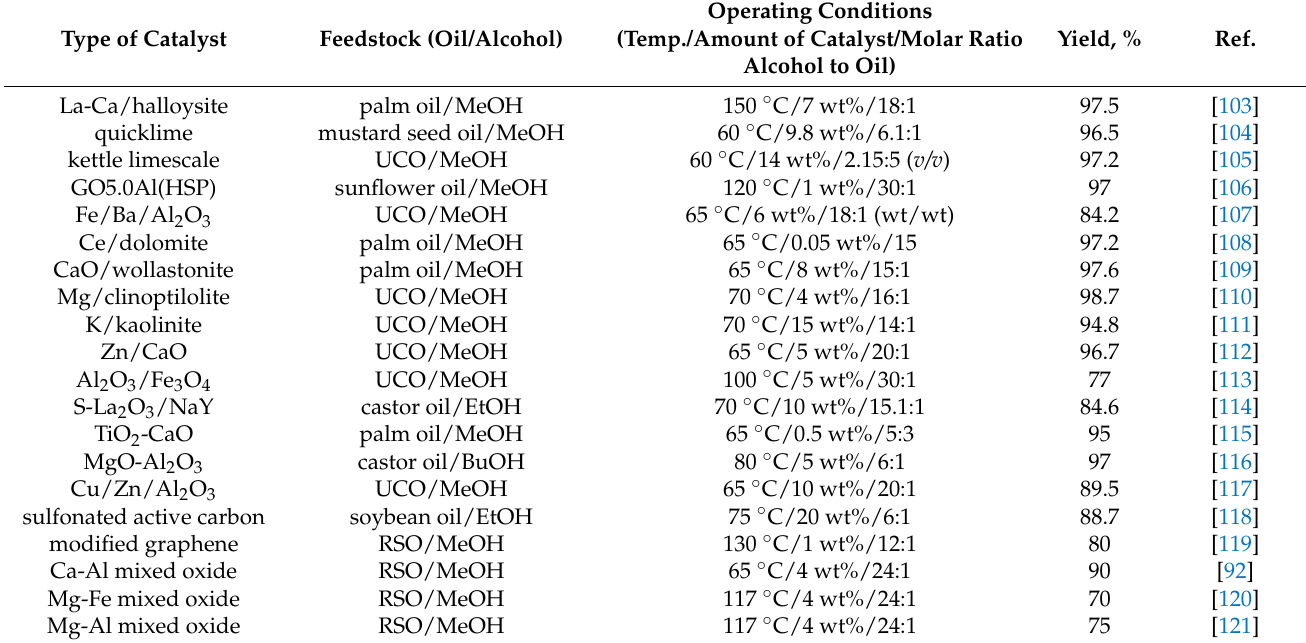
Table 5. The list of heterogeneous catalysts used in